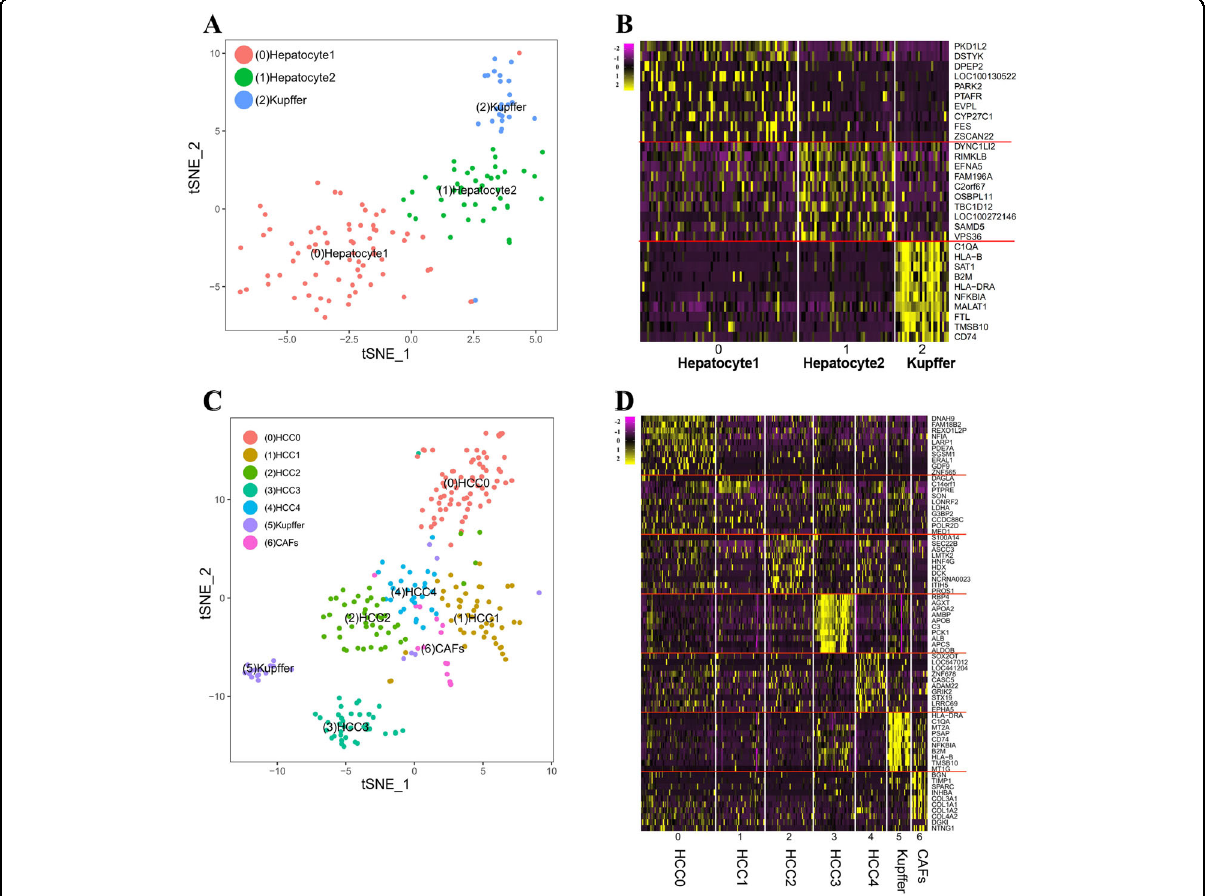
Fig. 1 Singles cell subpopulations and speci fi c DEGs identi fi cation in HCC tissues. A The t-SNE projected three main subclones of single cells clusters from para-tumor tissues. Each cluster was labeled with Arabic number. B Heatmap of the normalized top 10 DEGs of single cells clusters in three main subclones from para-tumor tissues. C The t-SNE projected seven main subclones of single cells clusters from HCC tissues. D Heatmap of the normalized top 10 DEGs of seven main subclones in HCC